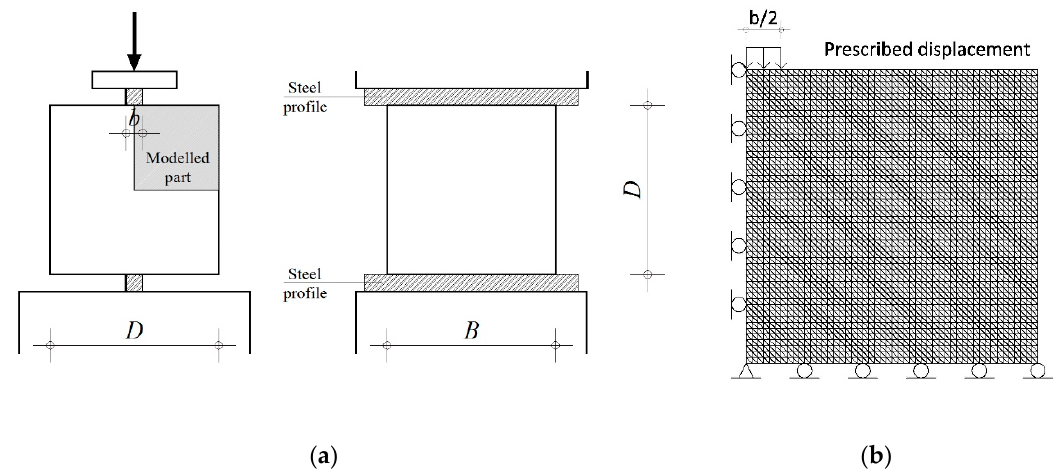
Figure 9. ( a ) Schematic drawing showing square test arrangement and ( b ) model for Finite Element numerical analysis, where the width and height D/2 = 50 mm, with b/2 = 6 mm.